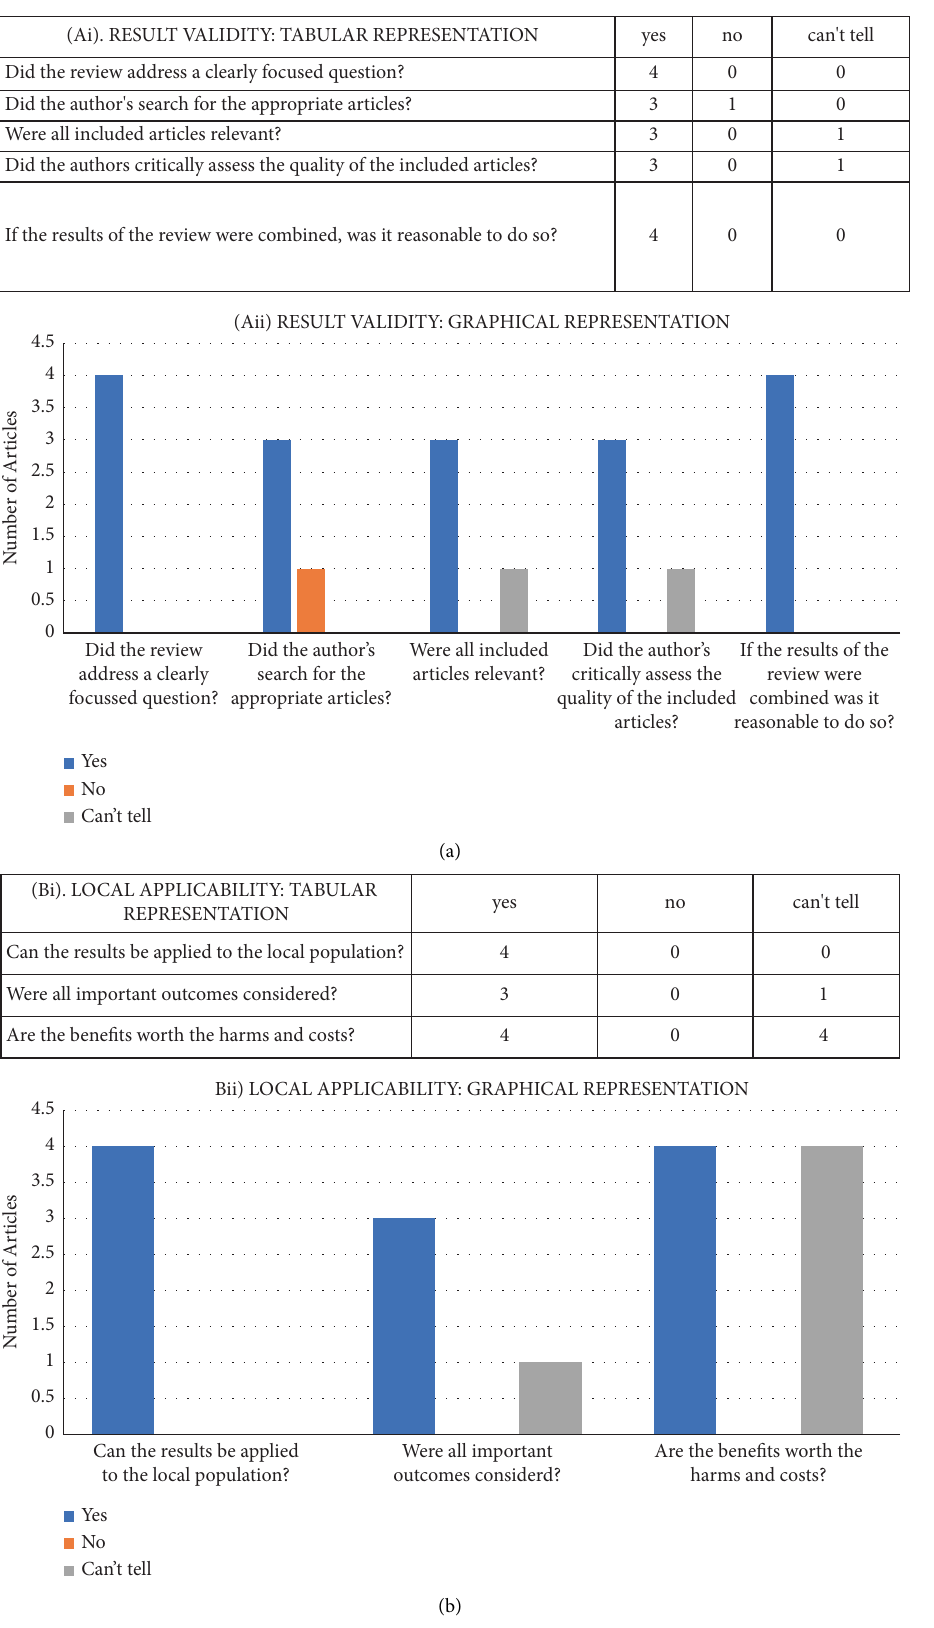
Figure 1: Summary of critical appraisal skills programme tool (CASP) for the evaluation of literature reviews with respect to (a) result validity and (b) local